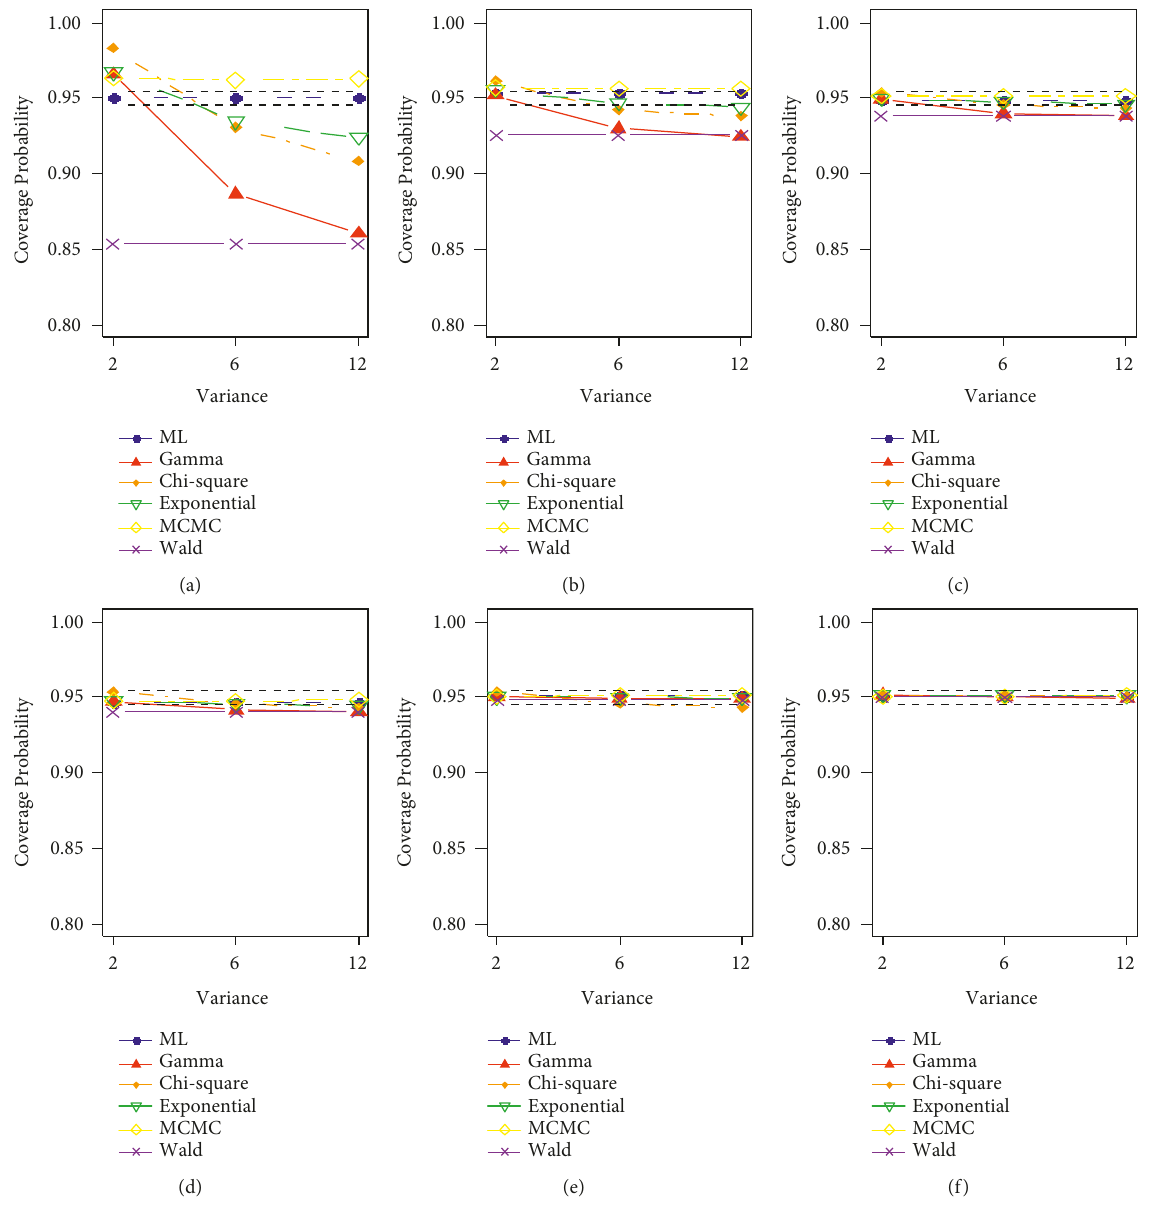
Figure 6: The trend of CP for all methods varies by variance at 95% confidence interval. (a) n � 10. (b) n � 50. (c) n � 100. (d) n � 300. (e) n � 500. (f) n �